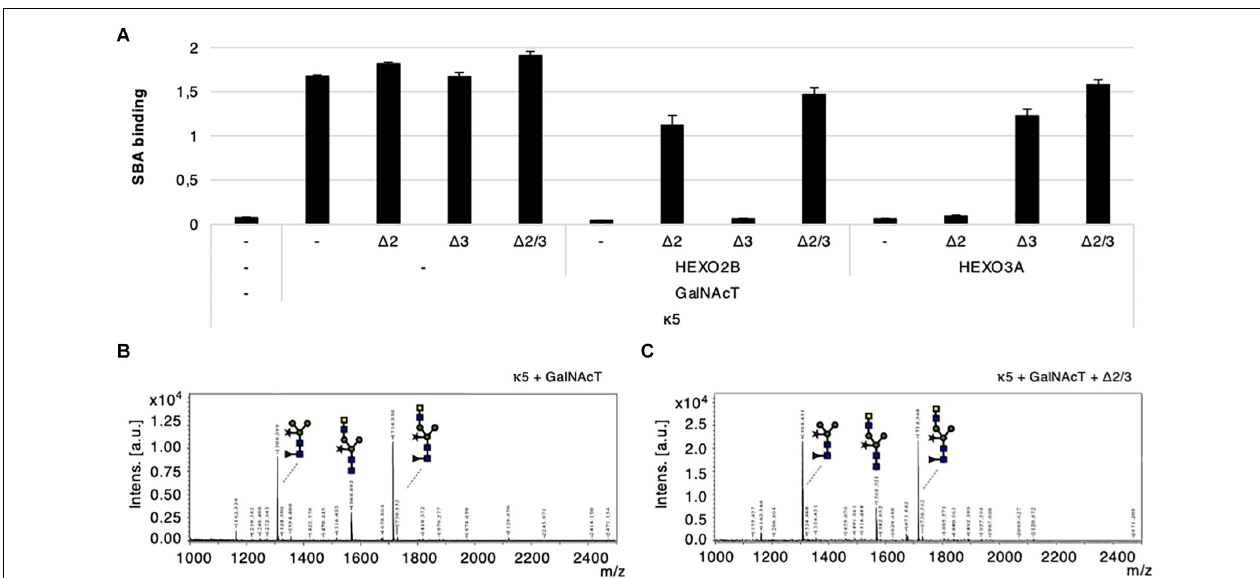
FIGURE 6 | Transient silencing of HEXO2 and HEXO3. Kappa-5 was co-expressed with CeGalNAcT and constructs targeting HEXO2 ( (cid:49) 2), HEXO3 ( (cid:49) 3), or both ( (cid:49) 2/3). The samples are grouped in three blocks depending on whether a HEXO variant (2B or 3A) was co-expressed. Control samples where a particular construct is not co-infiltrated is indicated as well (–). After isolation of the apoplast fluid (at 5 dpi) the presence of the LDN motif on kappa-5 N-glycans was analyzed. (A) Soybean agglutinin (SBA) binding assay for detection of terminal GalNAc. Lectin binding is measured as absorbance at 450 nm. (B,C) Kappa-5 was purified from the apoplast fluid and the N-glycan composition was analyzed by MALDI-TOF-MS. MS profiles are given for glucosaminidase treated N-glycans of kappa-5 upon co-expression of GalNAcT only (B) or combined with the hairpin construct targeting HEXO2 and HEXO3 ( (cid:49) 2/ (cid:49) 3; C ). m/z refers to mass-to-charge